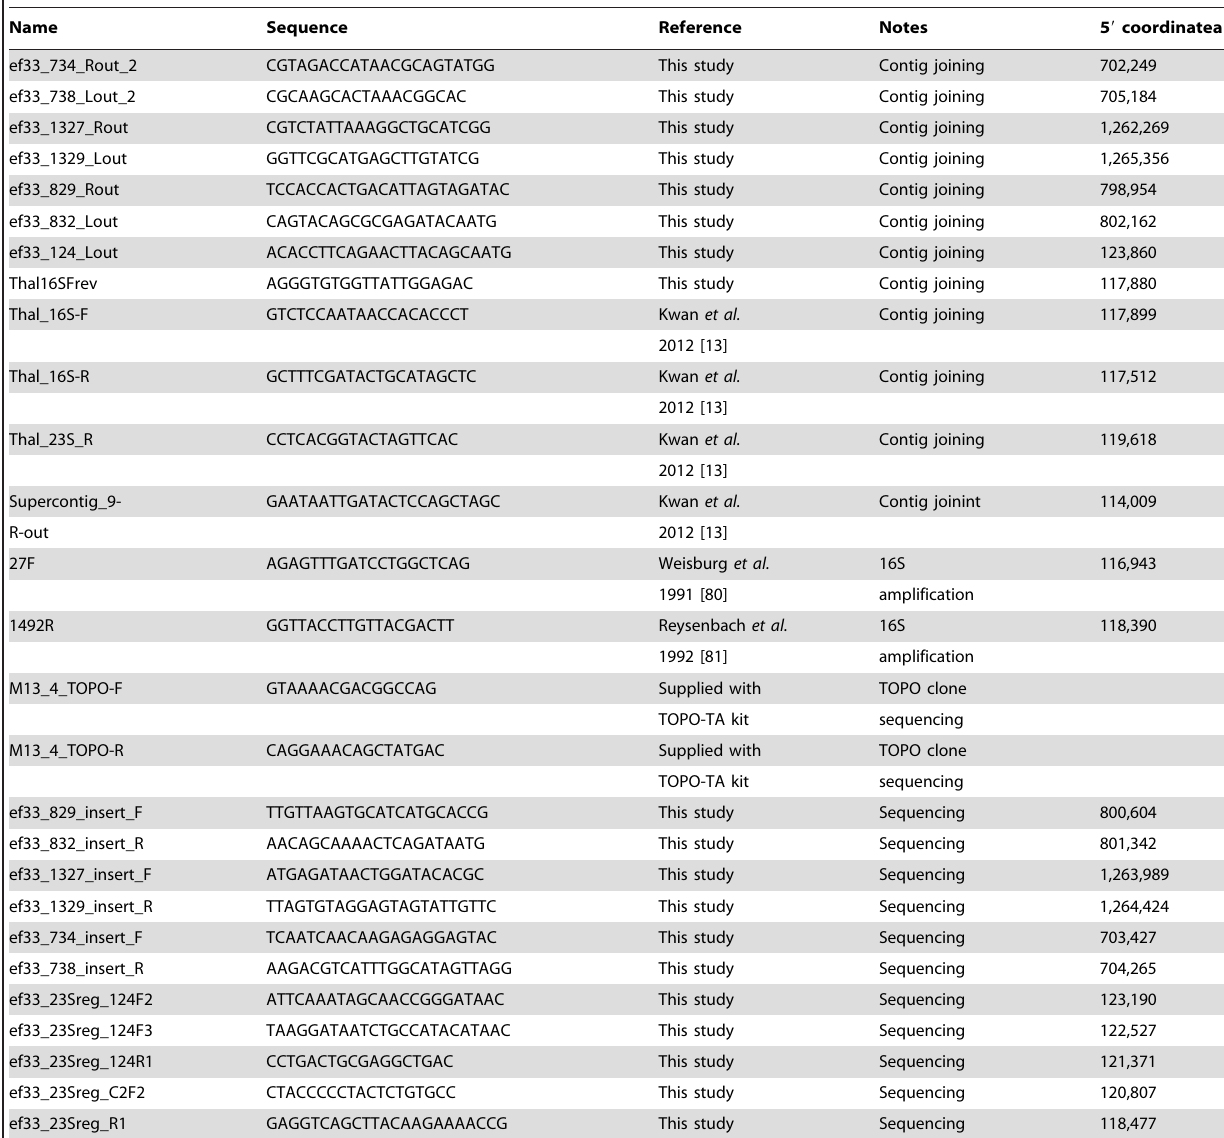
Table 7. Primers used in this